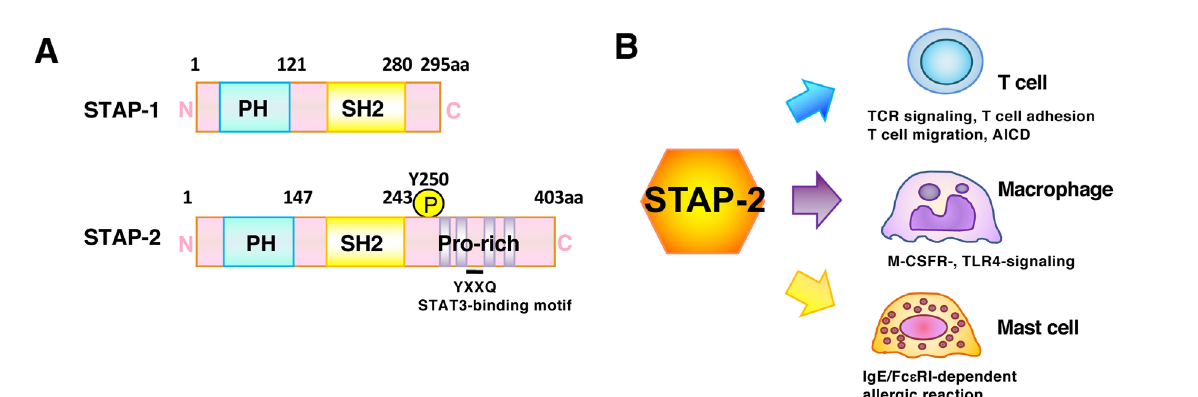
Figure 1. Structural and functional features of STAP-2 adaptor protein. (A) Structural characteristics of STAP-1 and STAP-2. Both consist of an amino N-terminal PH domain and a central SH2 domain. STAP-2, but not STAP-1, contains a carboxy C-terminal proline-rich domain and a STAT3-binding YXXQ motif. STAP-2 Tyrosine 250 (Y250) is phosphorylated by various protein tyrosine kinases; (B) STAP-2 modulates various immune signaling pathways. In T cells, STAP-2 modulates TCR-, integrin-, chemokine-, or Fas-mediated signals. In macrophages, STAP-2 modulates the M-CSFR- or TLR4-mediated signals. In mast cells, STAP-2 modulates the IgE/FcεRI -mediated signals. Thus, STAP-2 plays a physiological role in immune responses via these interactions. AICD: activation-induced cell death Note. Adapted from “Possible therapeutic applications of targeting STAP proteins in cancer,” by Matsuda T, Oritani K. Biol Pharm Bull. 2021;44:1810–8 (https://www.jstage.jst.go.jp/article/bpb/44/12/44_b21-00672/_article). CC